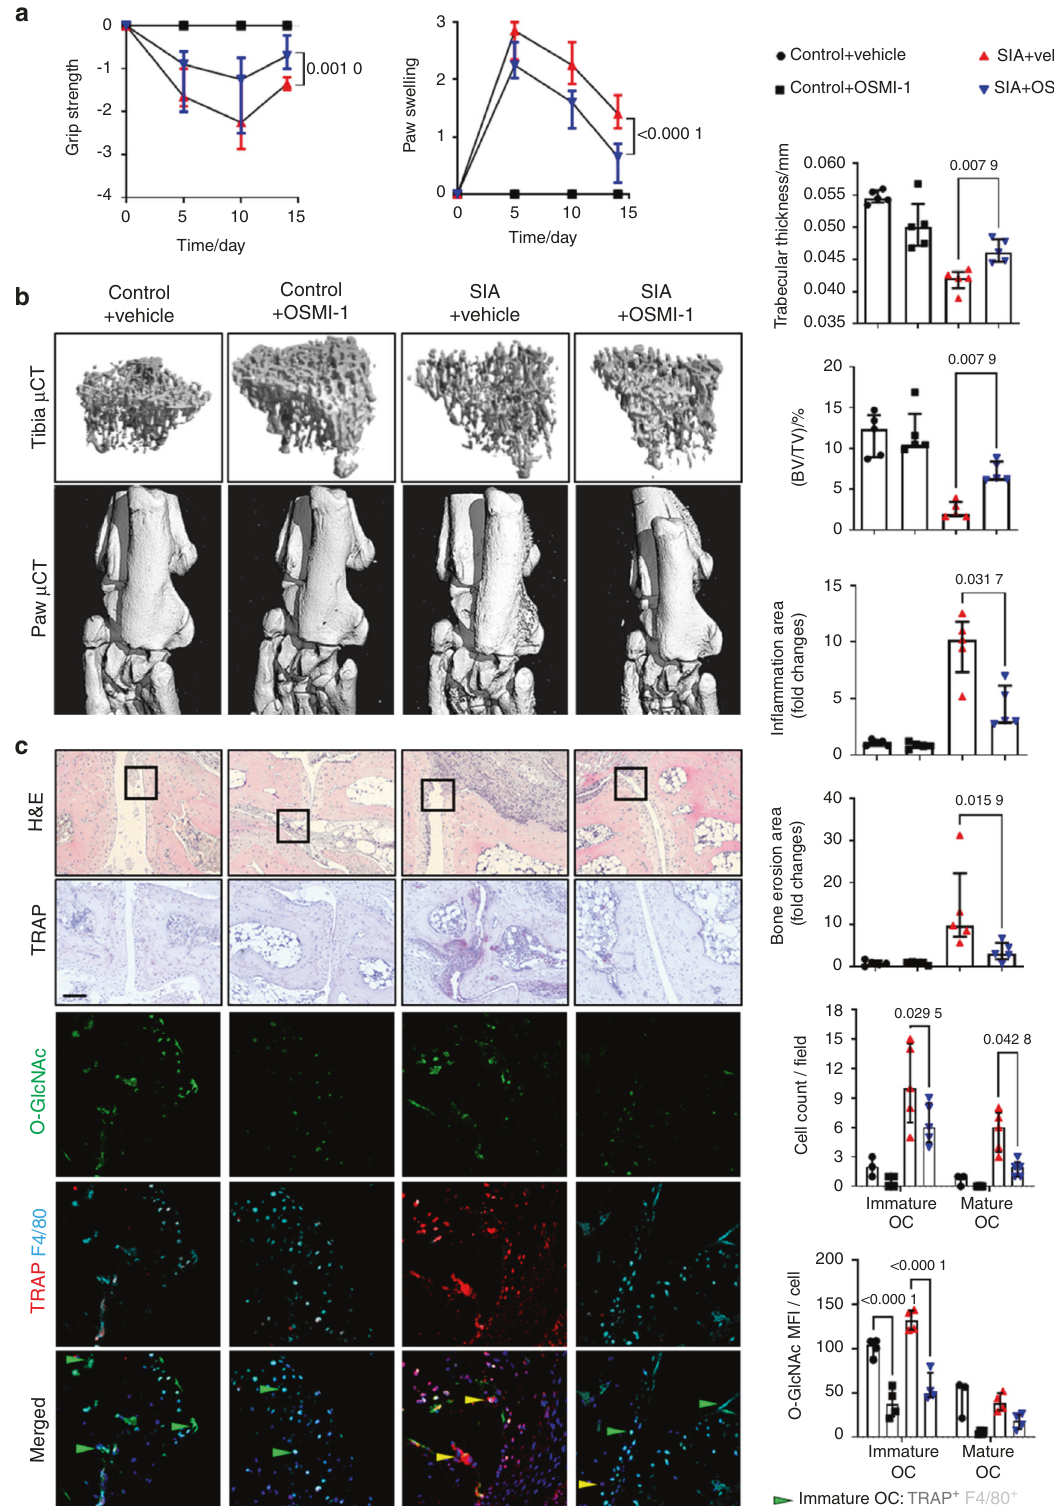
Fig. 4 Pharmacological inhibition of OGT ameliorates bone loss in serum-induced arthritis. a Grip strength and joint swelling in mice serum- induced arthritis (SIA) treated with OSMI-1. b Representative images and quanti fi cation of microcomputed tomography scans of bone tissue and analysis of the tibial bone structure. c Representative histological and confocal microscopy images of the tarsus with semi-automated, blinded quanti fi cation of H&E staining, TRAP staining, and O-GlcNAcylation. ( n ≥ 4 for all groups). All results are presented as median ± IQR. Horizontal scale bars are represented as 50 µm in IF images, 100 µm in histological staining. Statistical signi fi cance was determined by two- way ANOVA ( a, c ) or Mann – Whitney U-test ( b ). P -values are shown in the graphs. MFI mean fl uorescence intensity, OC